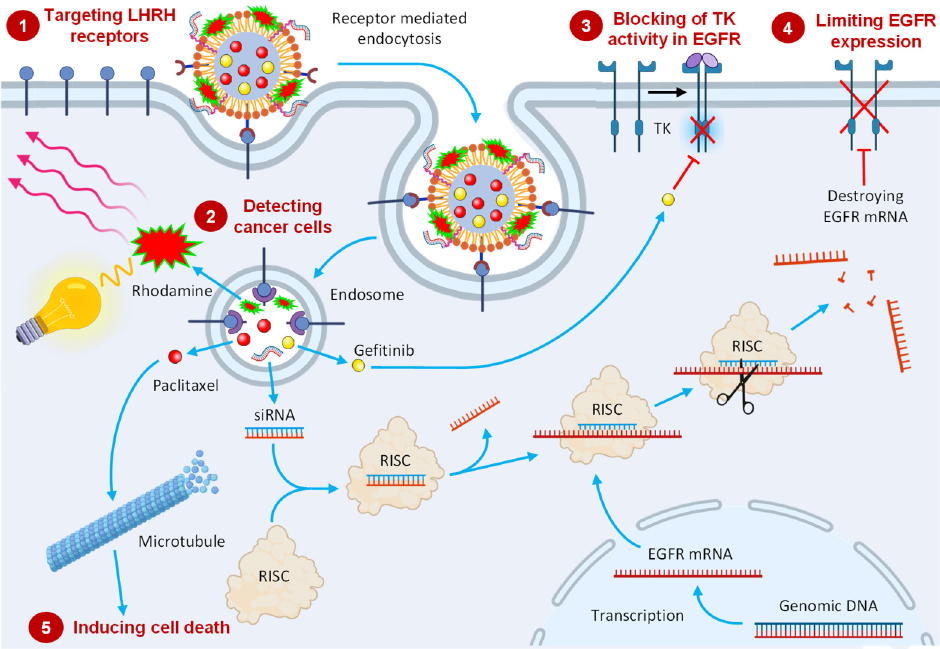
Figure 2. Schematic representation of internalization of a multifunctional cancer-targeted NLC-based delivery system with expected mechanisms of its anticancer action.